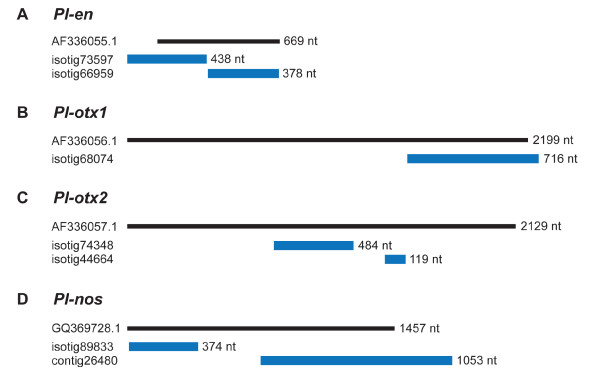
Transcriptome coverage of four previously known gene sequences. All four developmental genes previously sequenced from P. leidyi are represented in the transcriptome, although coverage is incomplete. Black bars represent previously known sequence for each gene (GenBank numbers on left) and blue bars represent transcriptome sequences matching to or extending the reference sequence (isotig/contig numbers on left).